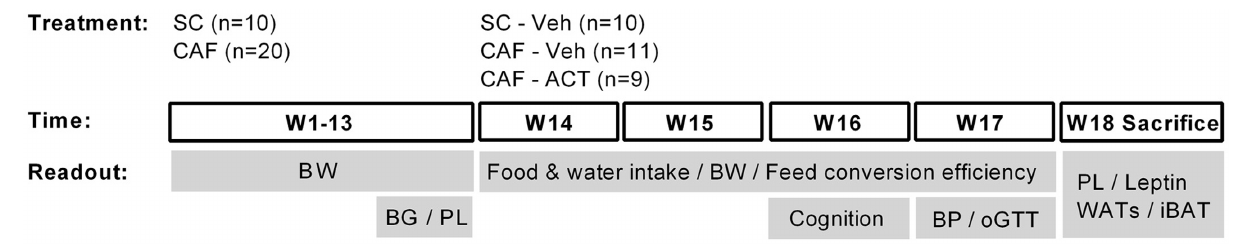
anACT-335827(CAF-ACT; n = 9)treatmentgroupbasedonanevendistribution of their blood glucose and plasma triglyceride levels, measured in week 11 and 13.Duringweeks14–17thefoodandwaterintakeandthebodyweightgainwas assessed, and the feed conversion efficiency calculated. In week 16 cognitive hippocampal function was assessed using a contextual fear paradigm. In week 17 blood pressure (BP) measurements and an oral glucose tolerance test (oGTT) were performed. In the beginning of week 18 all rats were sacrificed. Their plasma lipid (PL) and plasma leptin levels were assessed and the weight of white adipose tissue deposits (WATs) and the interscapular brown adipose tissue (iBAT) deposit was measured. See the Methods for further details.